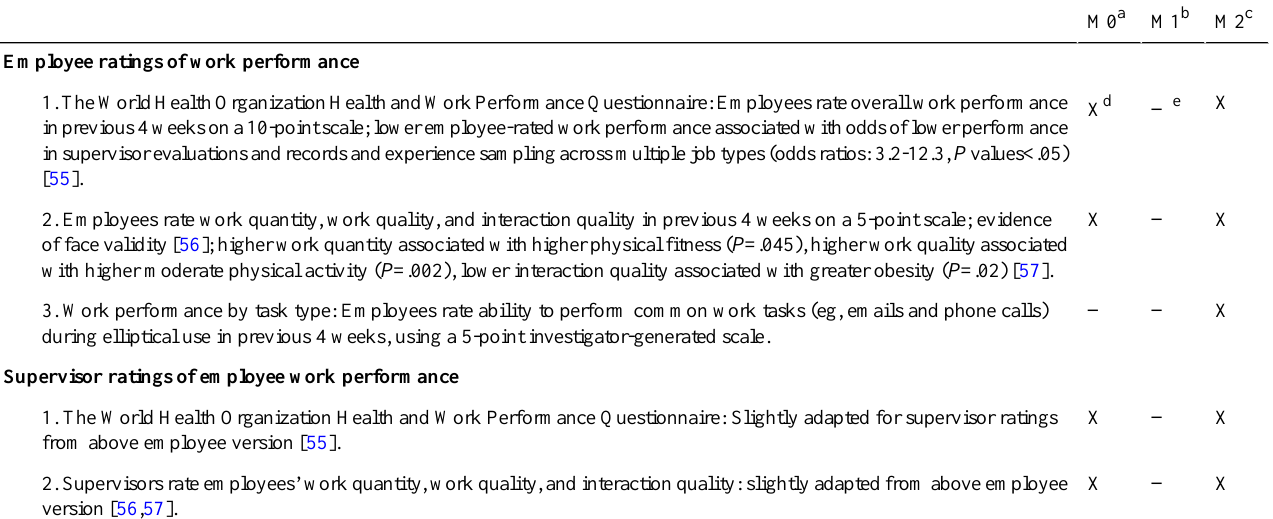
Table 1. Measures and measurement schedule.